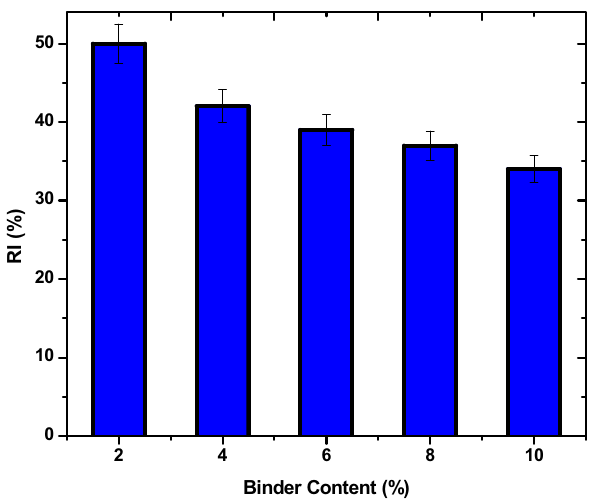
Figure 6. Influence of binder variation on reactivity index (RI) of the hybrid fuel briquettes.